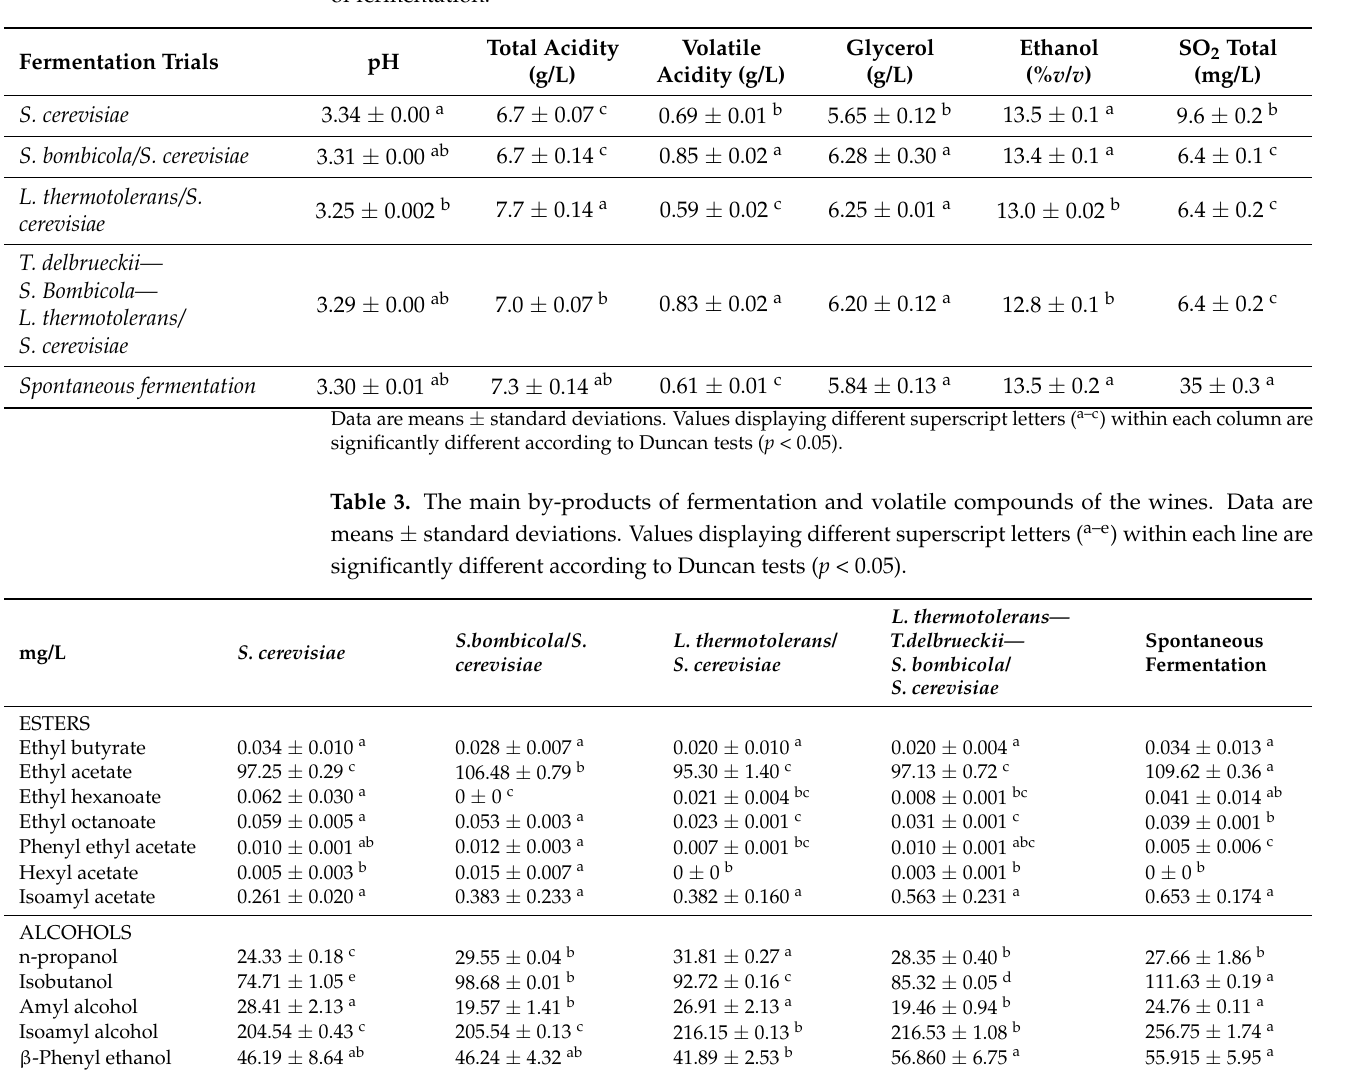
Table 2. Main analytical parameters of the Verdicchio wine obtained by different trials at the end of fermentation.